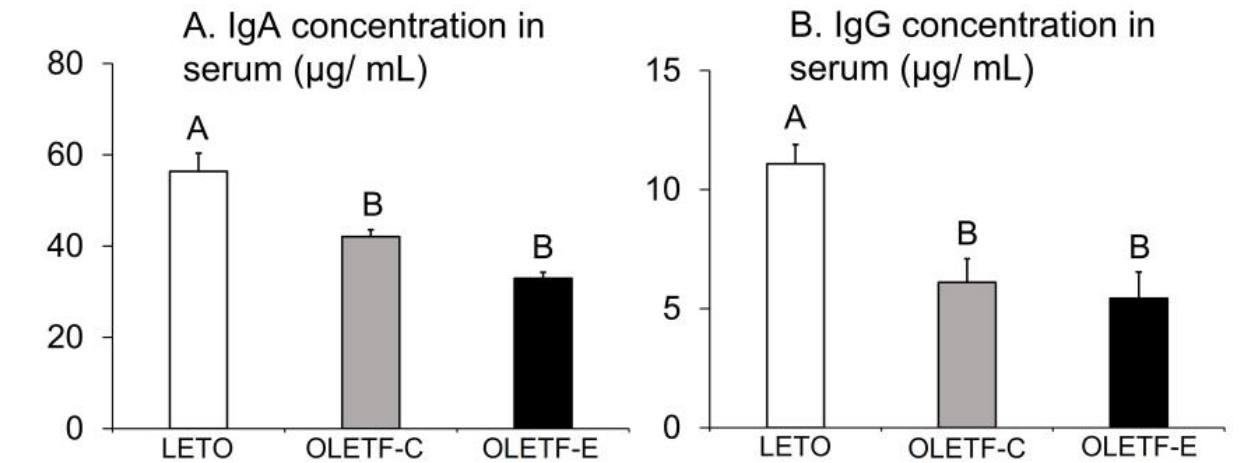
Figure 5. IgA concentration ( A ) and IgG concentration ( B ) in the serum 16 weeks after the start of this study. n = 5 per group. The bars represent mean values, and the error bars represent SE. Significant differences were determined using the one-way ANOVA, followed by multiple comparisons using Tukey’s post-hoc test. The letters represent significant differences between groups ( p < 0.05, Tukey’s post-hoc test).